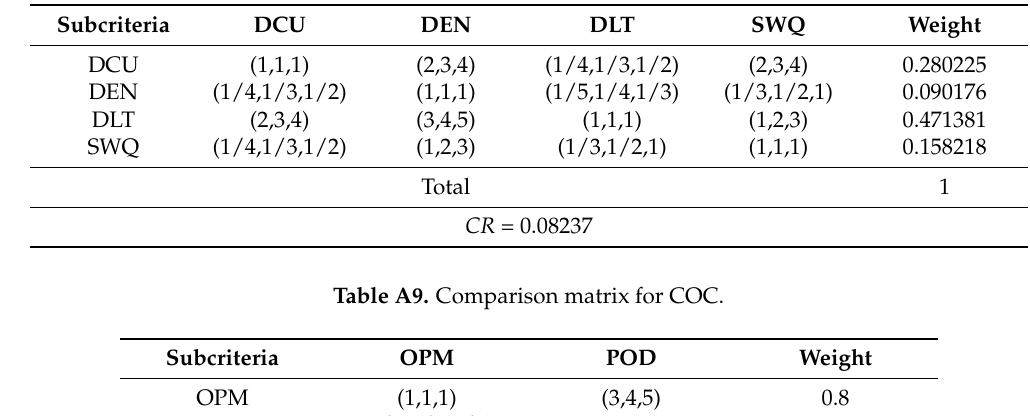
Table A8. Comparison matrix for TRF based on subcriteria.